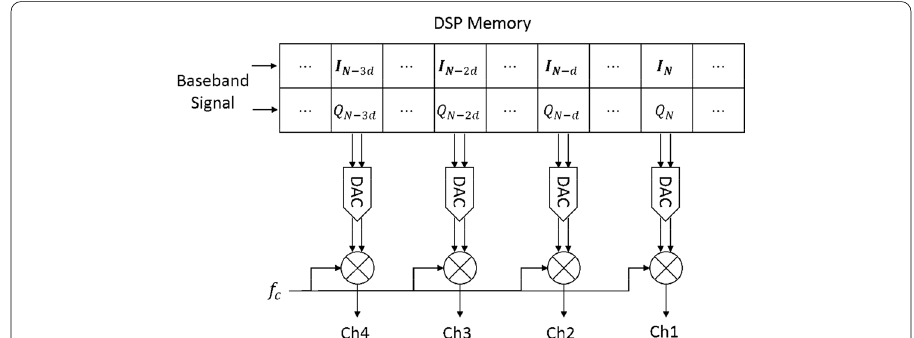
Fig. 6 Implementation of multiple delayed channels by digitally shifting the baseband signal. d is the offset length in the sampled baseband signal